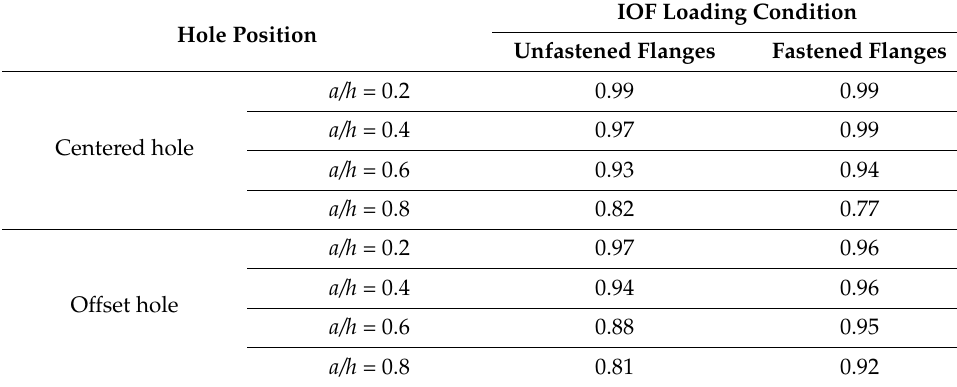
Figure 7. Web crippling strength reduction factor against a / h for cold-formed steel channel with ( a ) fastened flanges and offset web hole subjected to IOF and ( b ) unfastened flanges and offset web hole subjected to IOF. Table 3. Average web crippling strength reduction factor ( R ) of investigated